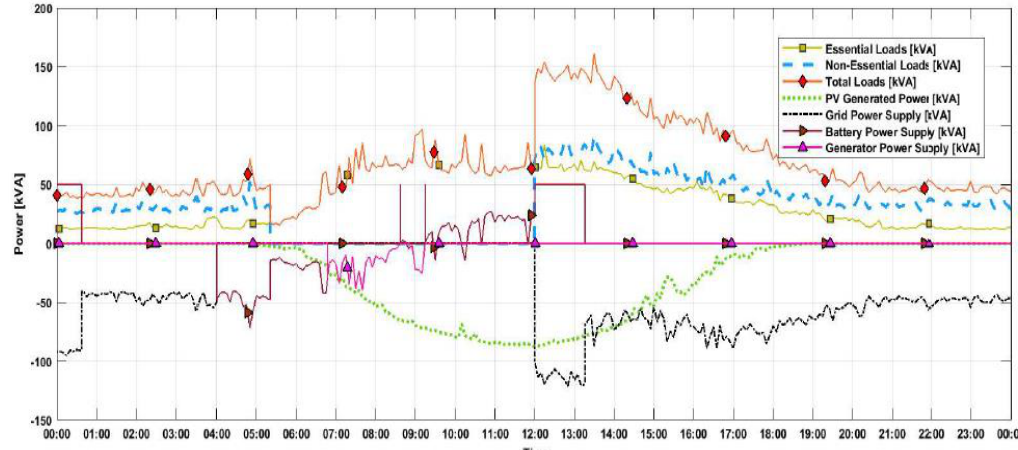
Figure 20. The behavior of MCAST micro-grid integrated with a 150 kWh BESS and 150 kVA diesel generator during an 8-h power cut at 4 a.m.